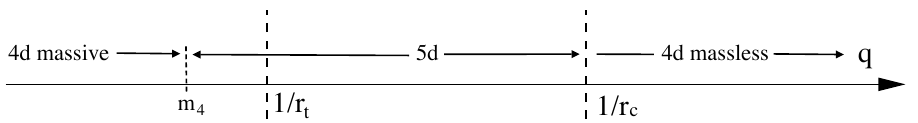
Figure 8 . Graphical representation of the di(cid:11)erent regimes (depending on momentum) of the brane-to-brane propagator, in the case r t > r c . In this example, we have chosen to set the massive gravity transition scale m 4 < 1 =r t , therefore it is only below m 4 that we have a four-dimensional single-particle-like